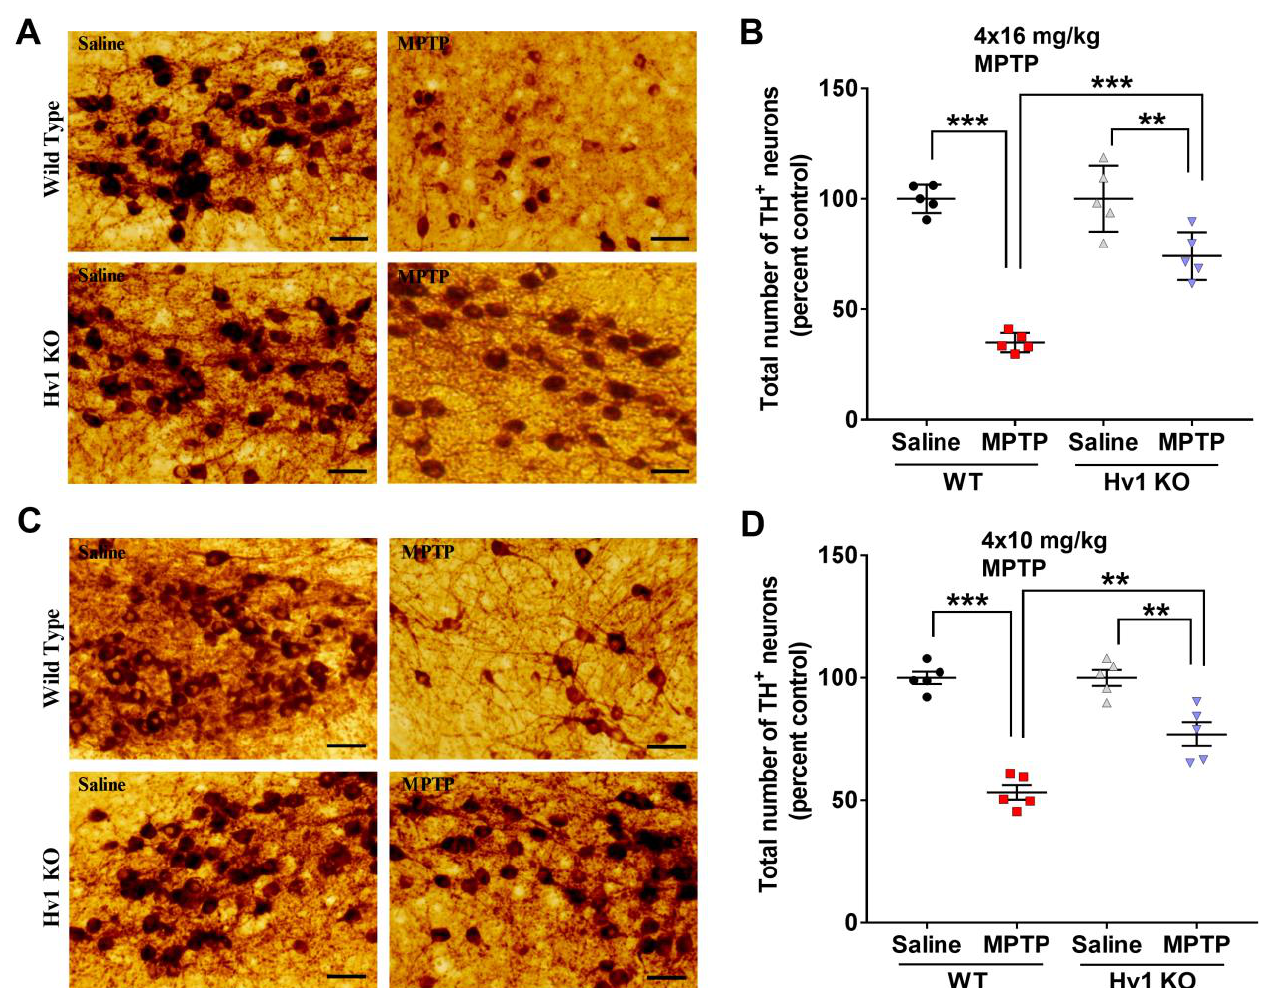
Figure 5. Hv1 deficient mice have diminished MPTP-mediated loss in TH-positive neurons in the substantia nigra. ( A , C ) Representative 20× DAB immunostaining images for TH in the SN of WT and Hv1 KO mice following acute 4 × 16 mg/kg ( A ) or 4 × 10 mg/kg ( C ) MPTP treatment, scale bar 50 µm. ( B , D ) Stereological counts for the total number of TH-positive neurons in the SN following 4 × 16 mg/kg ( B ) or 4 × 10 mg/kg ( D ) in each genotype. n = 5 mice per group. Asterisks denote statistically significant differences — ** p < 0.01, *** p < 0.001, using two-way ANOVA followed by Tukey’s multiple comparisons. ‘ns’ indicates not statistically significant. Error bars denote the standard error of the mean.